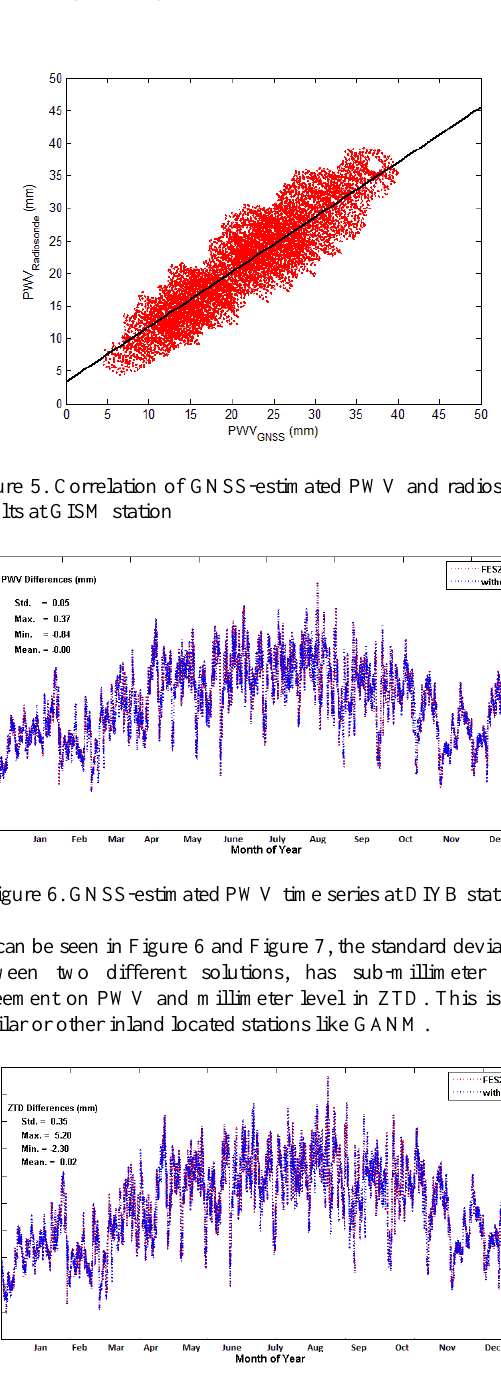
Figure 7. GNSS-estimated ZTD time series at DIYB station